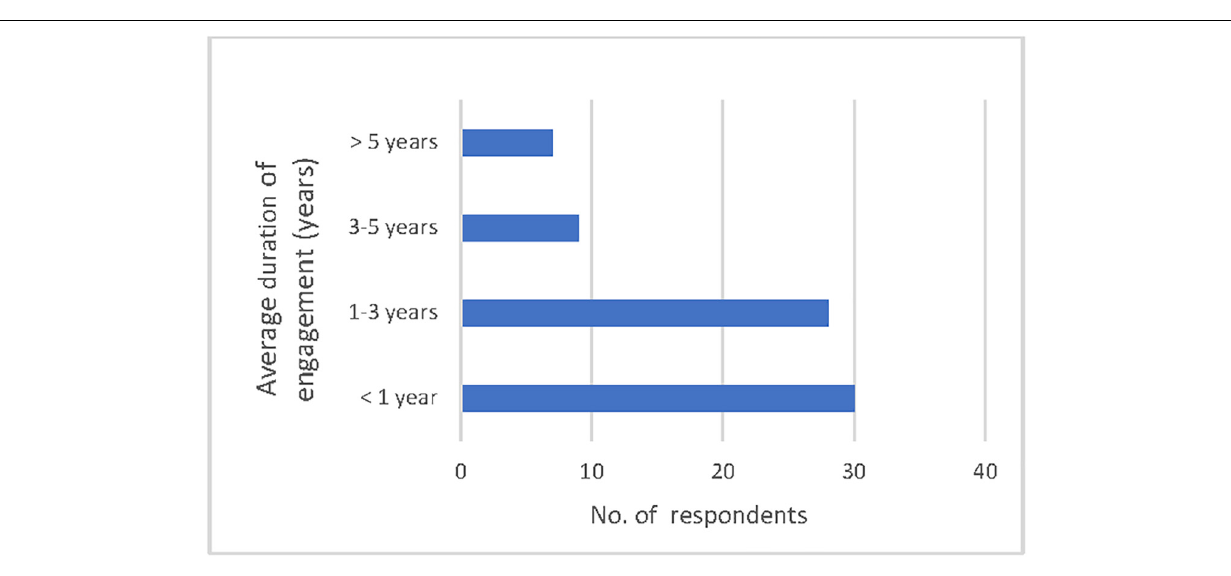
FIGURE 2 | Average duration of Indigenous engagements in marine research projects measured by number of survey